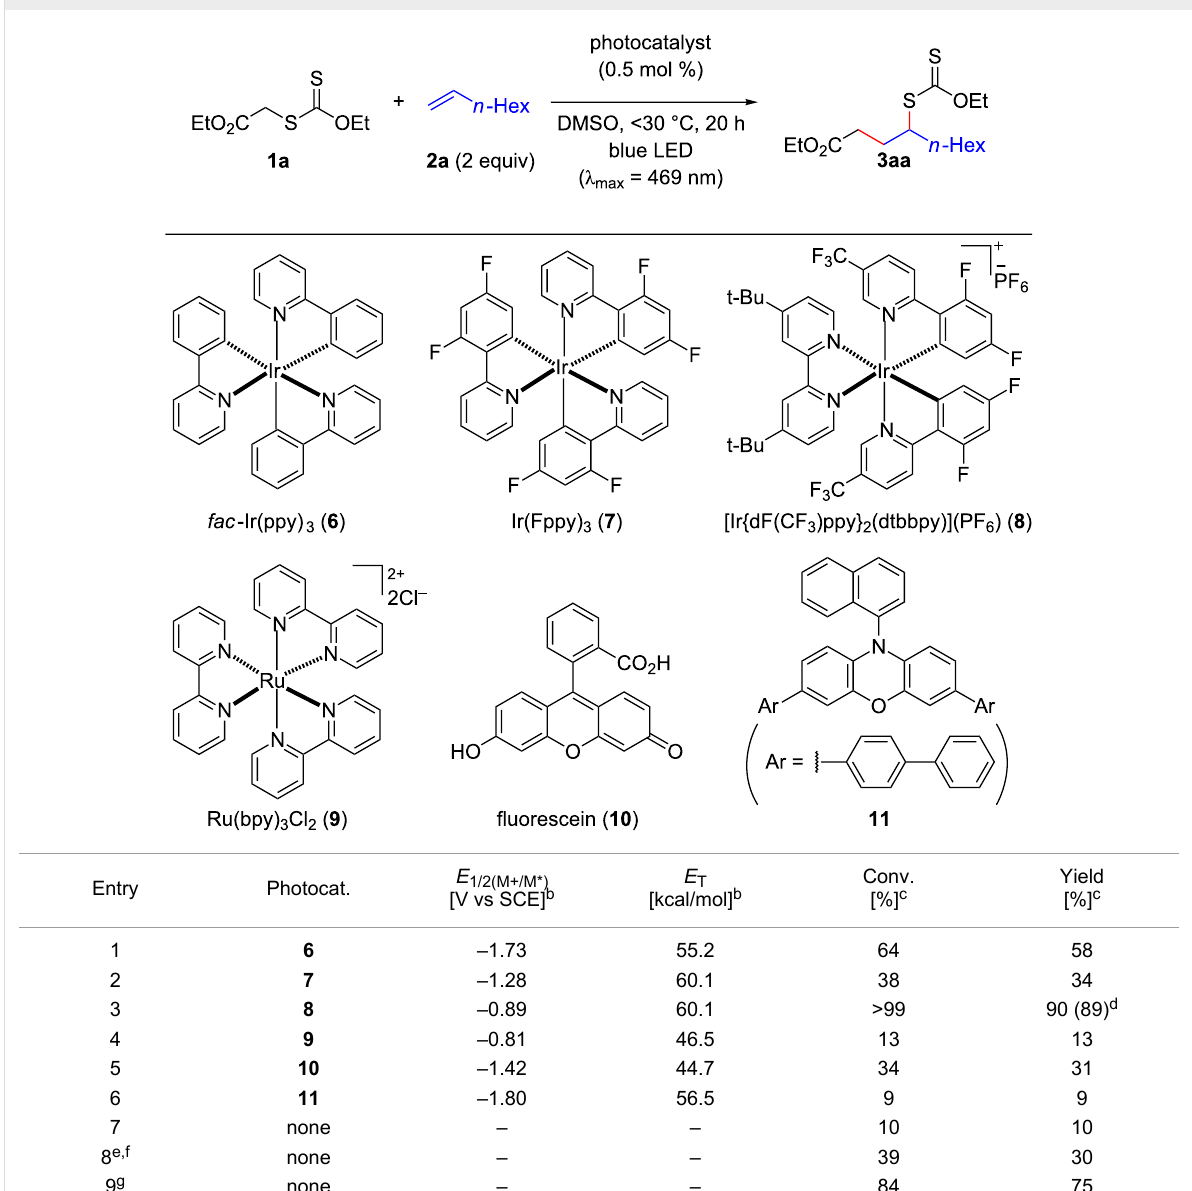
Table 1: Optimization of reaction conditions.